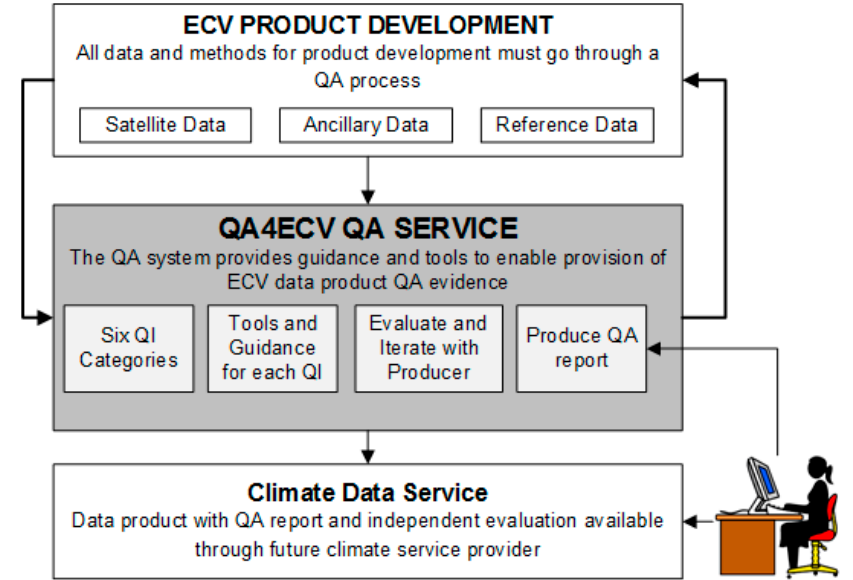
Figure 1. The Quality Assurance for Essential Climate Variables (QA4ECV) quality assurance (QA) system framework overview. The system comprises a set of six quality indicator (QI) categories to extract meaningful quality information about the data products that users should take into account when applying the data for climate applications.